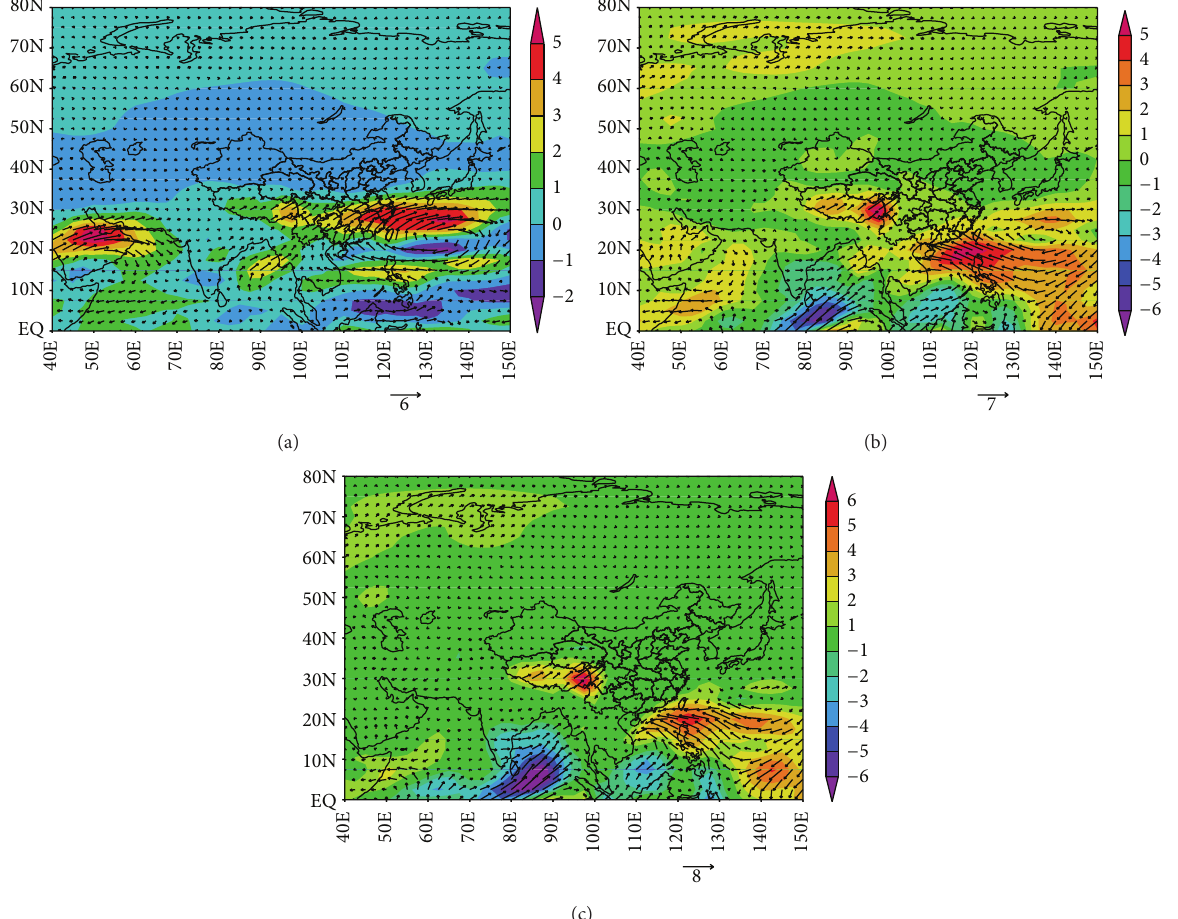
Figure8:MoisturefluxdeparturefromJanuary11to30,2008,at700hPa(a),850hPa(b),and925 hPa(c)(theshadedarearepresentsmoisture flux anomaly, the wind vector made by latitude moisture flux anomaly, and zonal moisture flux anomaly; unit: g ⋅ cm −1 ⋅ s −1